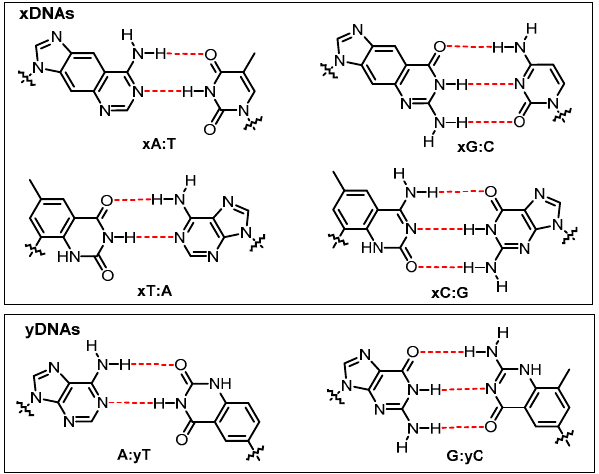
Figure 9. Structures of sized-expanded bases in xDNA and yDNA.